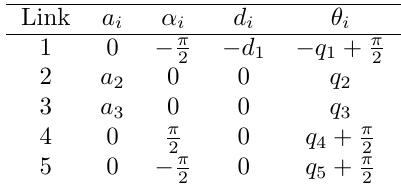
Table 1: DH-parameters - Crane-payload